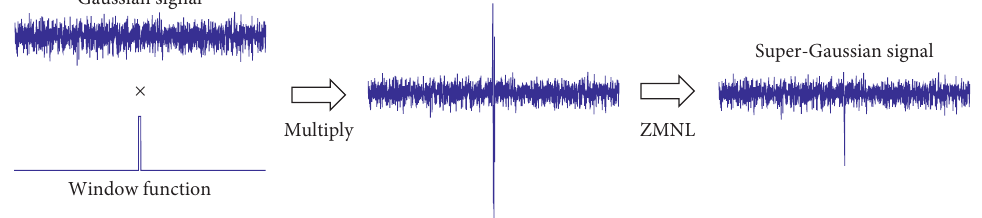
Figure 13: Schematic diagram of the improved ZMNL